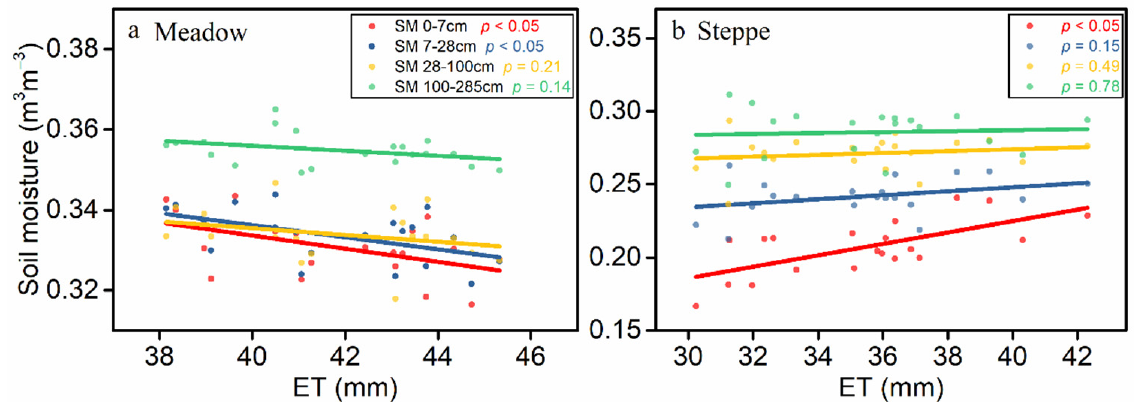
Figure 8. Relationship between monthly mean evapotranspiration (ET, mm) and soil moisture content (m 3 m − 3 ) in May–June in the meadow ( a ) and the steppe ( b ). The color lines indicate the least- squares fit between ET and soil moisture in each depth (red: 0–7 cm; blue: 7–28 cm; yellow: 28–100 cm; green: 100–285 cm) and the corresponding p indicates the significance level.